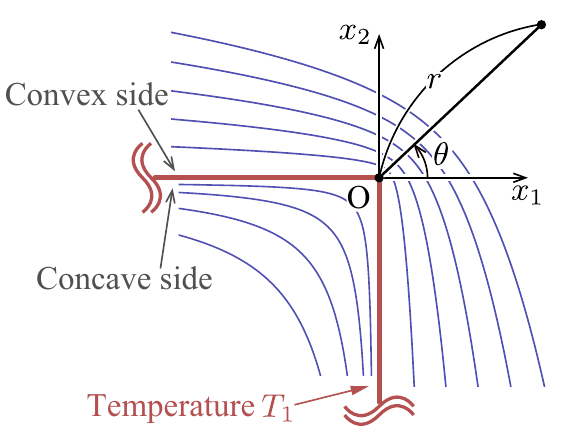
Figure 12. Normal stress p 11 along the vertical part of the type I shape, i.e., x 1 for various Kn in the case of T 1 / T 0 0 for various Kn . Filled symbols are used for Kn D / 2 ( b ) x 1 = −